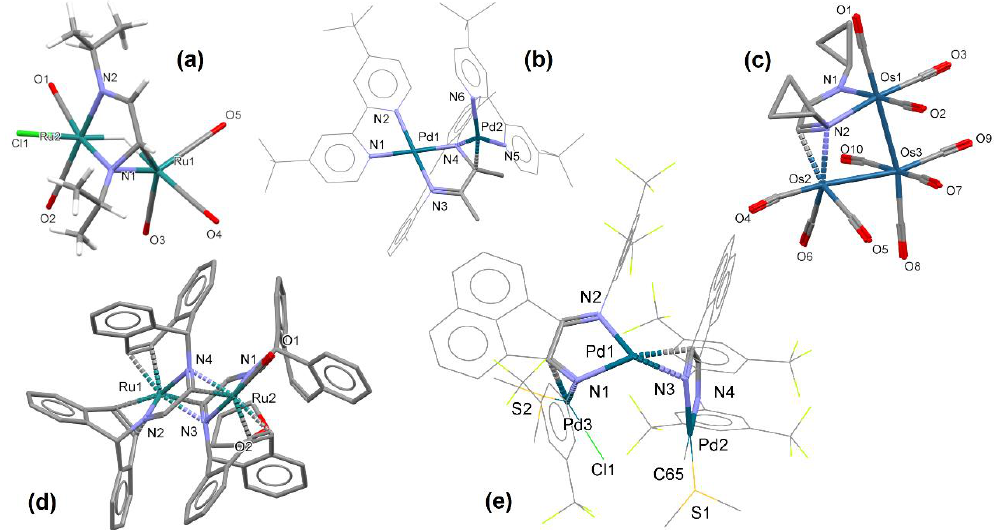
Figure 8. ( a ) Six electrons donor coordination mode (6e μ 2 - κ 2 - N,N’: η 2 - C’=N’ ) of the DAB ligand observed in the monohydride metal carbonyl complex of Ru [147] (CSD Refcode WAGKOE); ( b ) unusual three-membered PdCN ring with the η 2 -coordinated imidoyl group [148] (CSD Refcode OKAYUU); ( c ) triosmium 6e μ 2 - κ 2 - N,N’: η 2 - C’=N’ complex with the DAB related ligand [149] (CSD Refcode GIRDIU); ( d ) dimeric structure of the complex of the DAB ligand with ruthenium with the coordination mode (6e μ 2 - κ 2 - N,N’: η 2 - C’=N’) [150] (CSD Refcode YARYEY) and ( e ) mixed valence tripalladium 6e μ 2 - κ 2 - N,N’: η 2 - C’=N’ complex with the non-innocent acenaphthenequinone-based